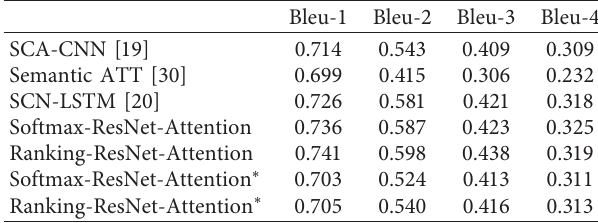
Figure 7: Examples of attending to the correct object ( white indicates the attended regions, words below the figure indicate the labelling of spatial relation features). (a) Havest. (b) Begging. (c) Search. (d) Salvage. Table 1: Results of caption-image retrieval on the Flickr30K dataset.